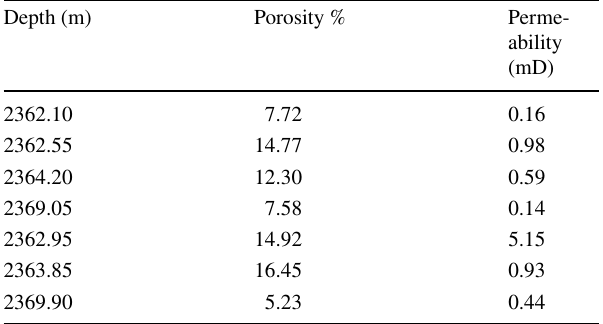
Table 4 The porosity and permeability values of Kömürlü Formation sandstones, Aşkale